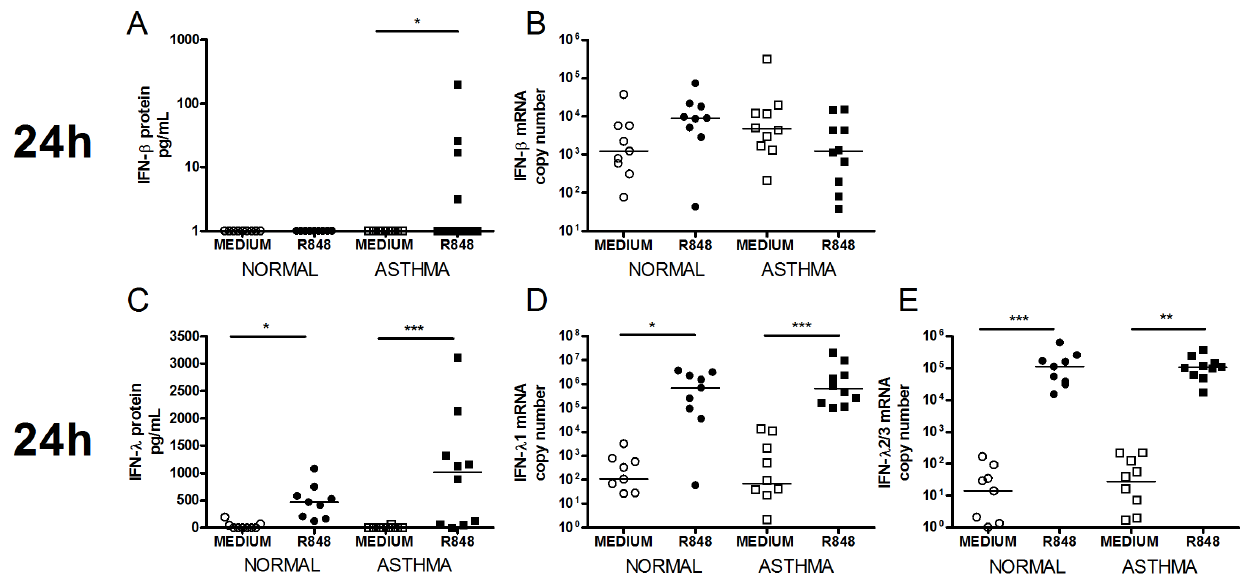
Figure 2. TLR7 stimulation induced type I and III IFN in HBECs. Graphs depict IFN- b protein [A], IFN- b mRNA [B], IFN- l protein [C], IFN- l 1 mRNA [D] and IFN- l 2/3 mRNA [E] at 24 h following stimulation with R848. Squares represent asthmatics, circles represent non-asthmatics. *=p , 0.05, **=p , 0.01, ***=p , 0.001.